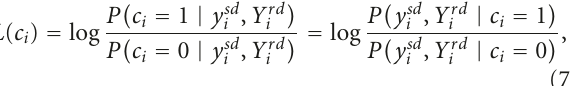
several constituent codes to the destination according